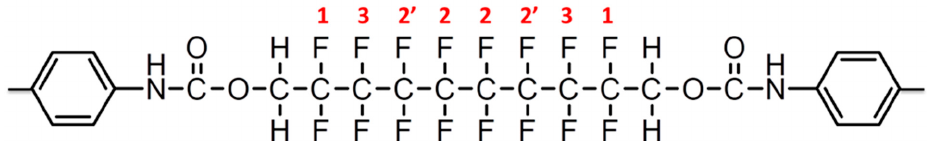
Figure 6. Structure of the biodegradable fluorine-containing polyurethanes.